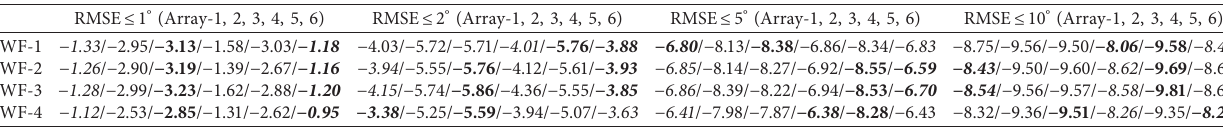
Table 3: SNR (dB) values when arrays can produce 50% correct results using 257 snapshots under different estimation accuracies. RMSE ≤ 1 ° (Array-1, 2, 3, 4, 5, 6) RMSE ≤ 2 ° (Array-1, 2, 3, 4, 5, 6) RMSE ≤ 5 ° (Array-1, 2, 3, 4, 5, 6) RMSE ≤ 10 ° (Array-1, 2, 3, 4, 5, 6)